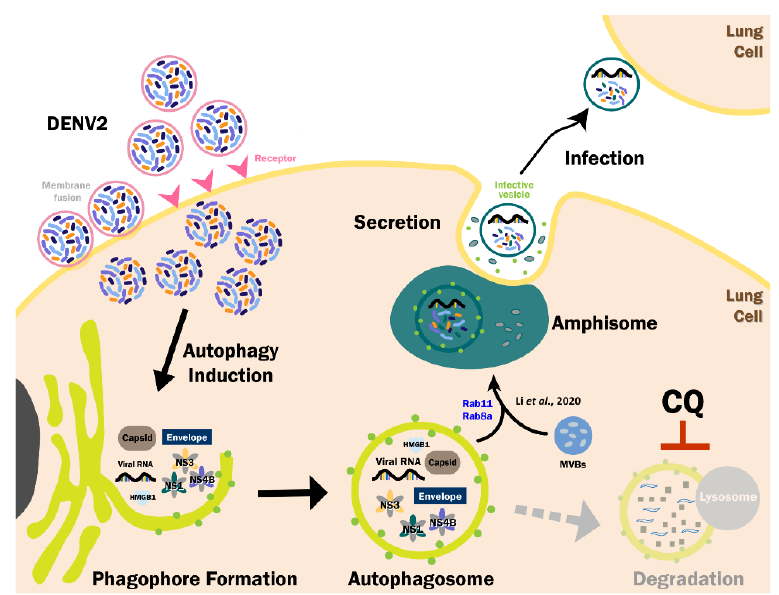
Figure 6. A schematic hypothesis of the role of autophagy in DENV infection and exocytosis. DENV2 triggers the endoplasmic reticulum to form the isolation membrane in the presence of multiple factors, followed by progression to form the mature autophagosome, which may selectively recruit DENV2 proteins and RNA, including negative-stranded and full-length DENV RNAs. These infectious autophagic vesicles may be released from the infected cells partially through the secretory autophagy pathway.